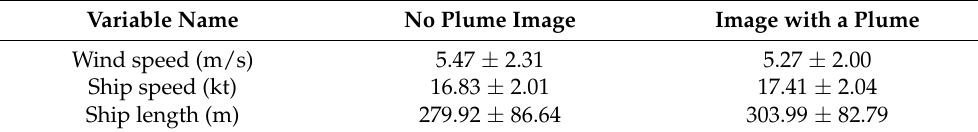
Figure 17. Distribution of the dataset features for the images, where there were no visible ship plumes distinguished, and for the images, where there was a visually distinguishable ship plume. Table 5. Average and standard deviation for the dataset features for the images, where there were no visible ship plumes distinguished, and for the images, where there was a visually distinguishable ship